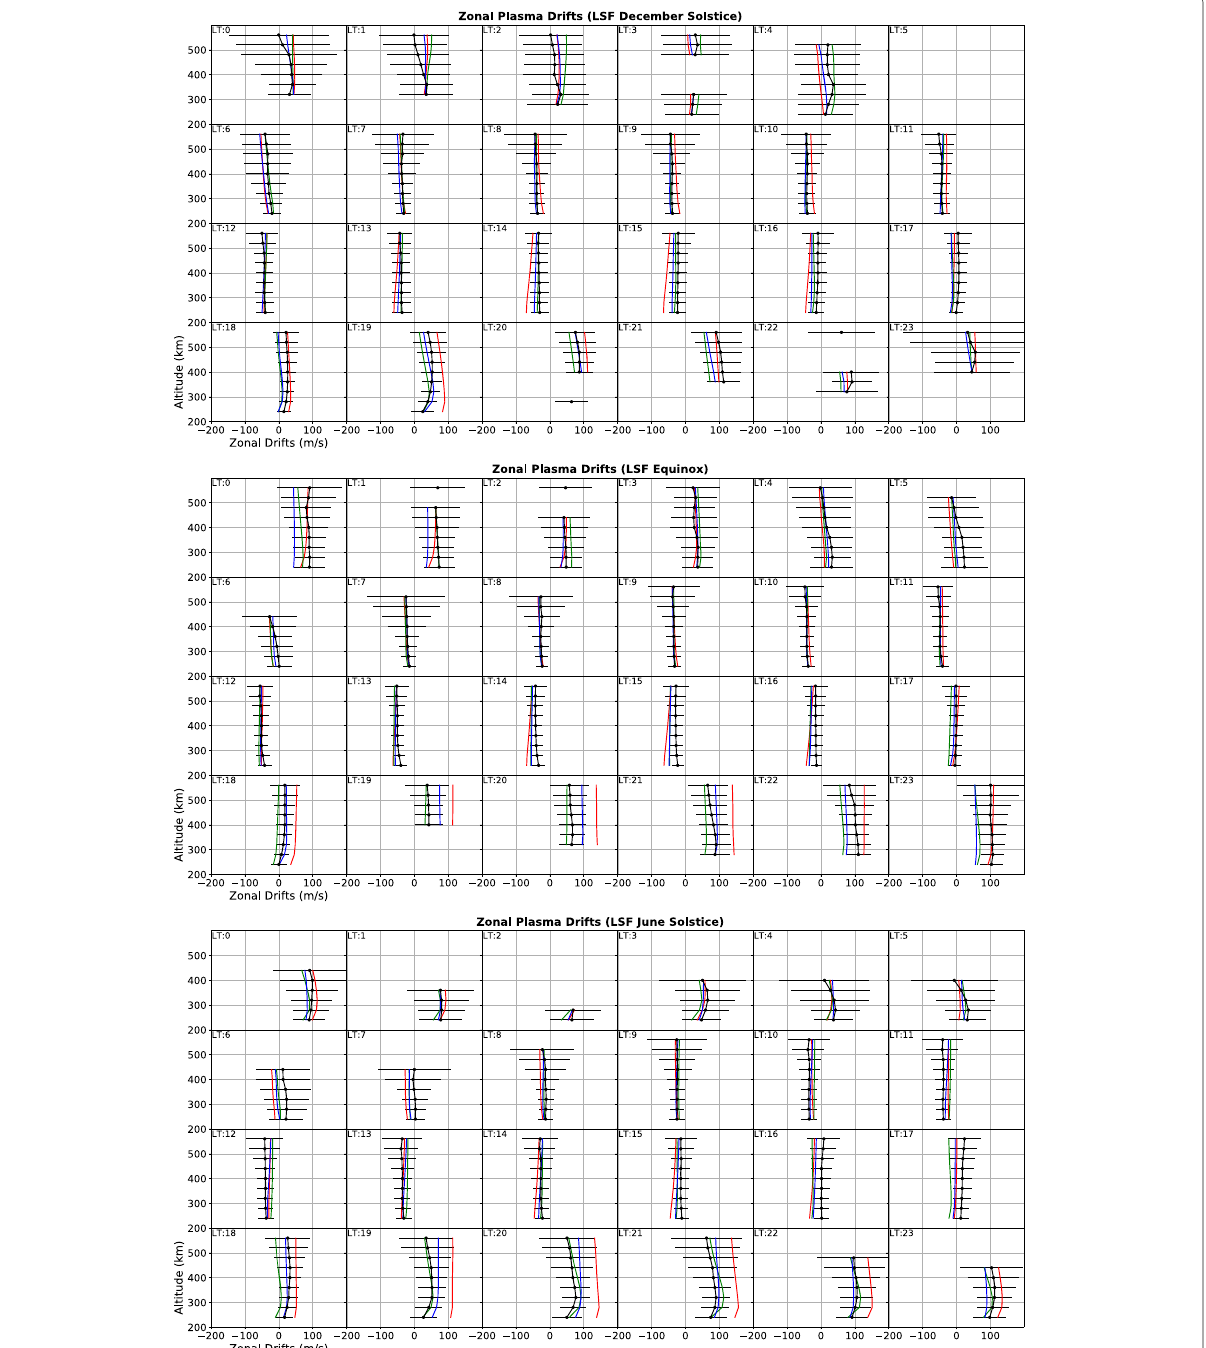
Fig. 4 Altitude profiles for the three seasons during LSF conditions. The blue, green, and red lines represent model zonal plasma drifts using HWM14, HWM07, and HWM93, respectively. The black curves and error bars represent the average and standard deviations of the Jicamarca zonal plasma drifts,